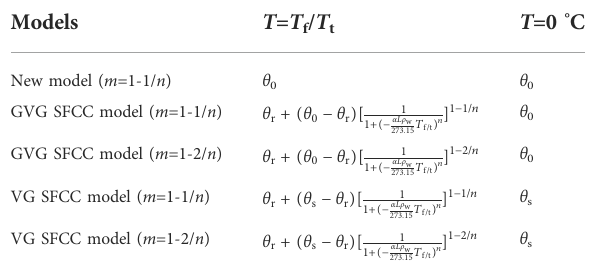
TABLE 5 Boundary conditions for different SFCC models.